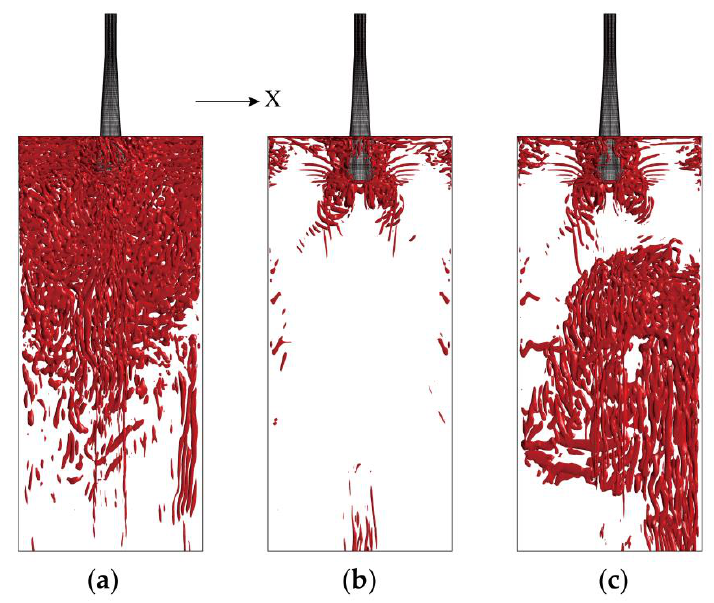
− 2 ): ( a ) Case A; ( b ) Case B; ( c ) Case